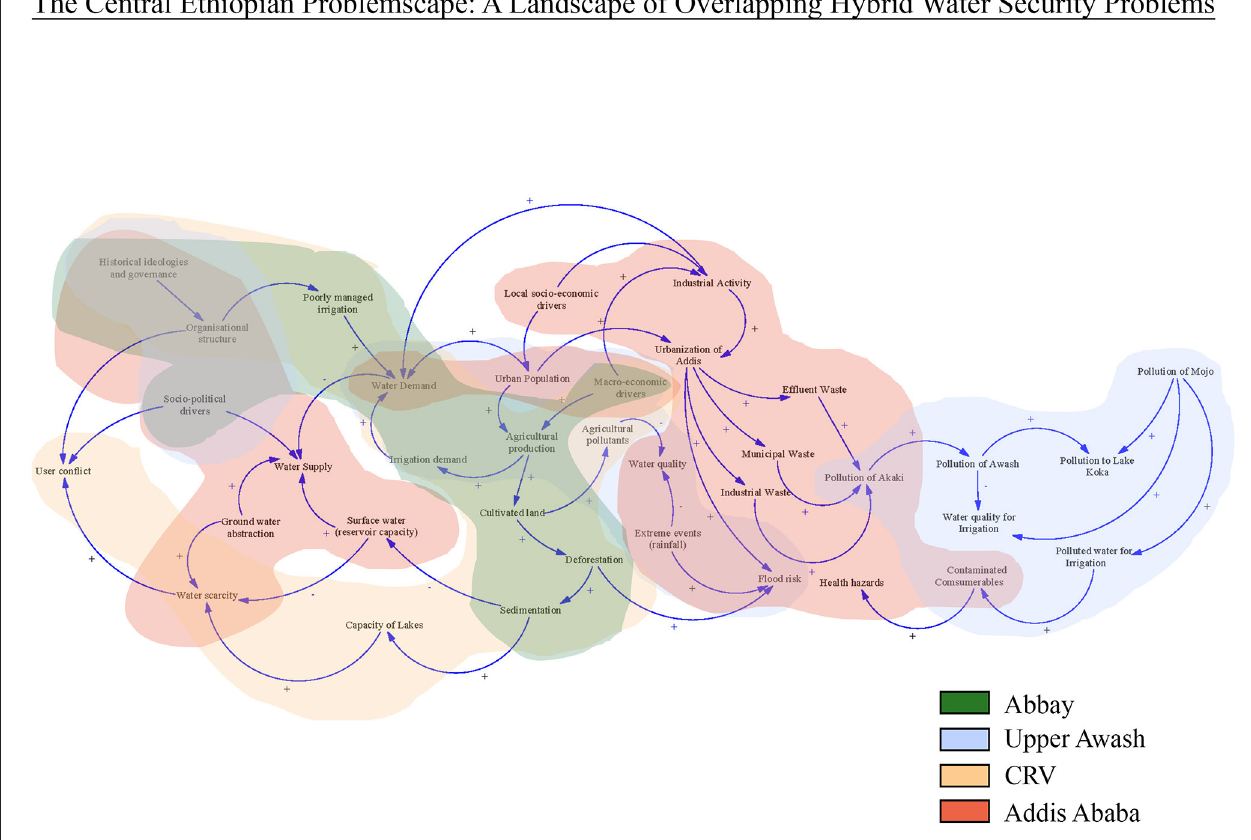
FIGURE 7 | The conceptual CEC problemscape.